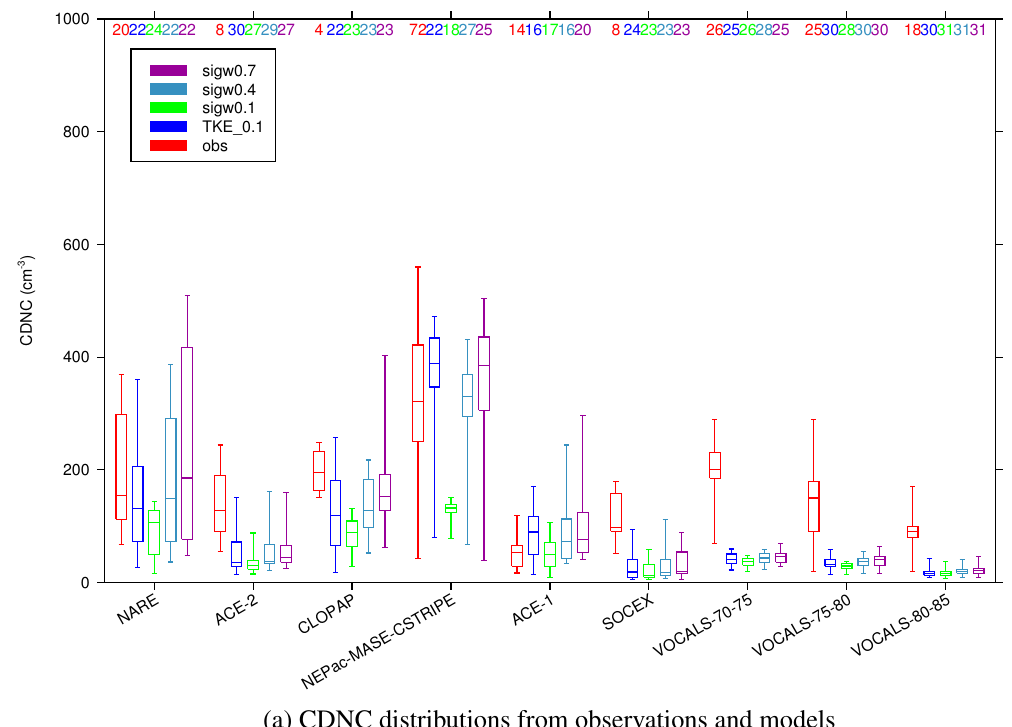
Figure 7a. Box-and-whisker plots showing minimum, 25th percentile, median, 75th percentile and maximum values of (a) CDNC and (b) σ w , from flight campaign observations (where reported) in red, and each model configuration (TKE_0.1 in blue, sigw0.1 in green; sigw0.4 in turquoise and sigw0.7 in purple) for marine stratiform flight campaigns. Sample size is given across the top of each figure.